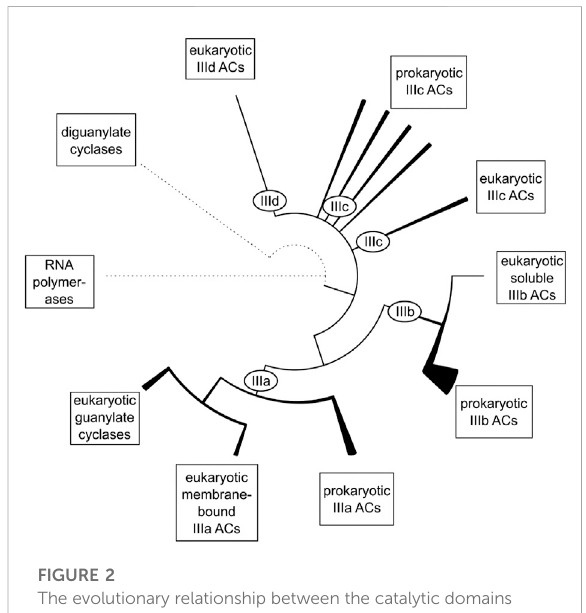
FIGURE 2 The evolutionary relationship between the catalytic domains of class III adenylyl cyclases. Dotted lines represent remote homology to other protein families. Solid lines represent relations between major subgroupsofclass IIIACs.Within classIIIACs, the line thickness symbolizes the diversity of domain